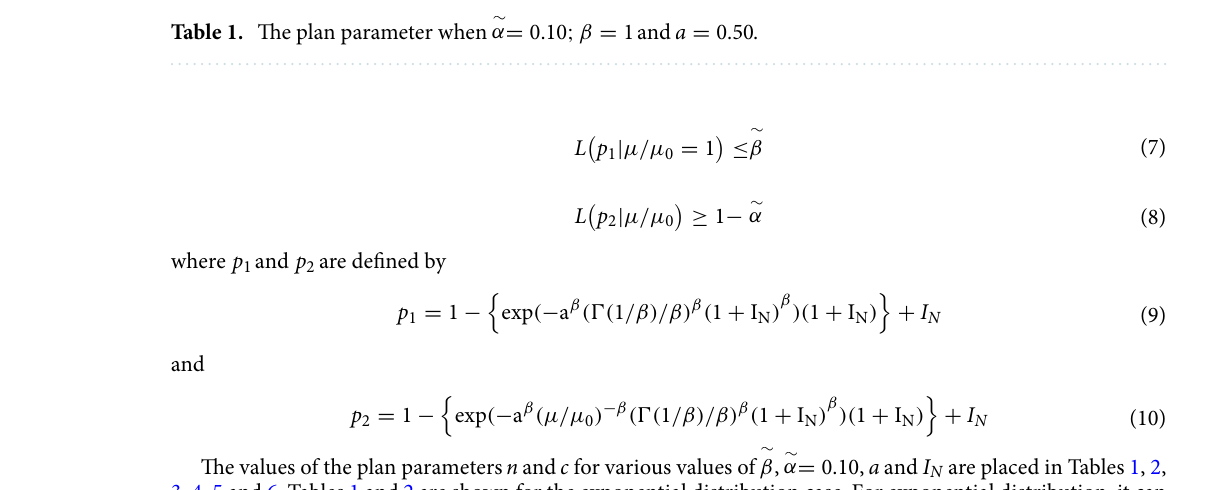
Table 1. The plan parameter when